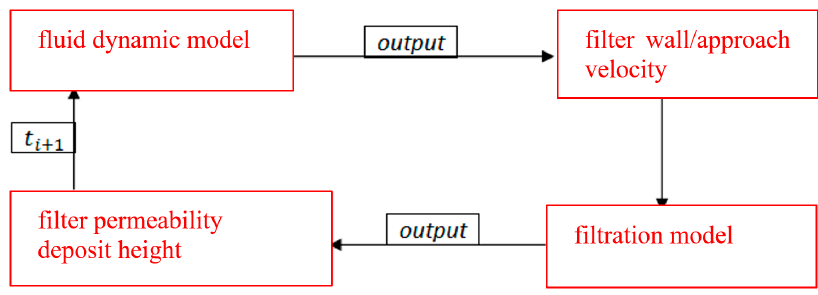
Figure 2. Calculation scheme.